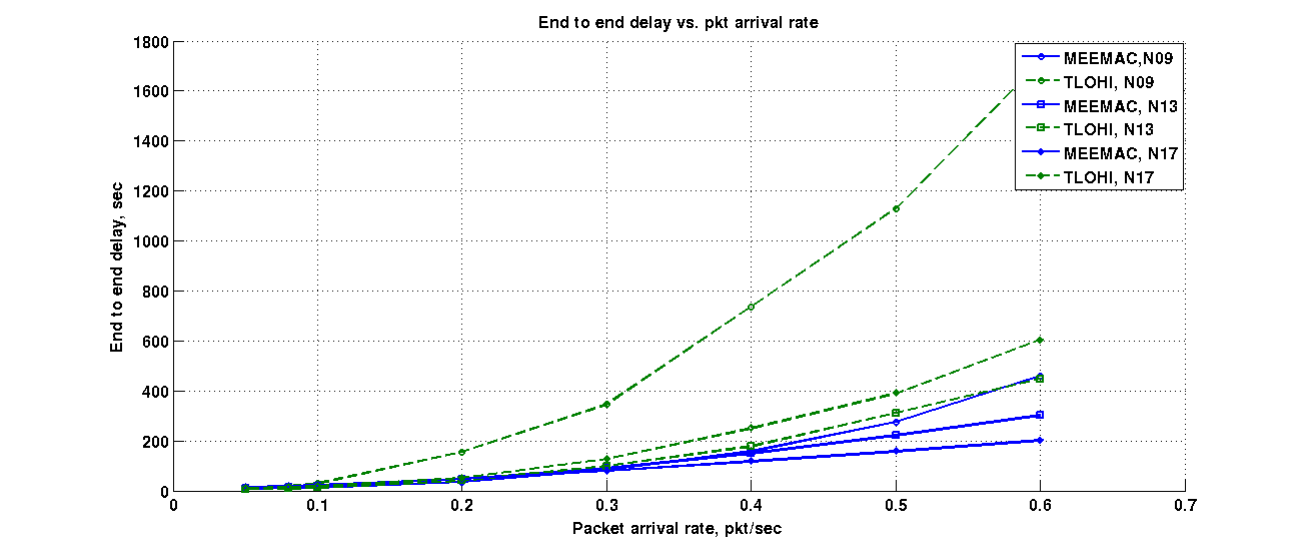
Figure 17. End to end delay vs. arrival rate for multi-hop